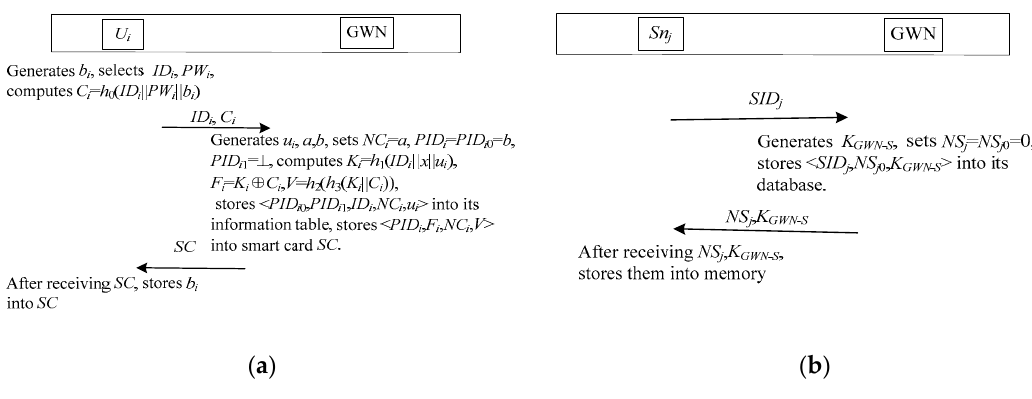
Figure 4. The registration phase. ( a ) The user registration phase; ( b ) The sensor node registration